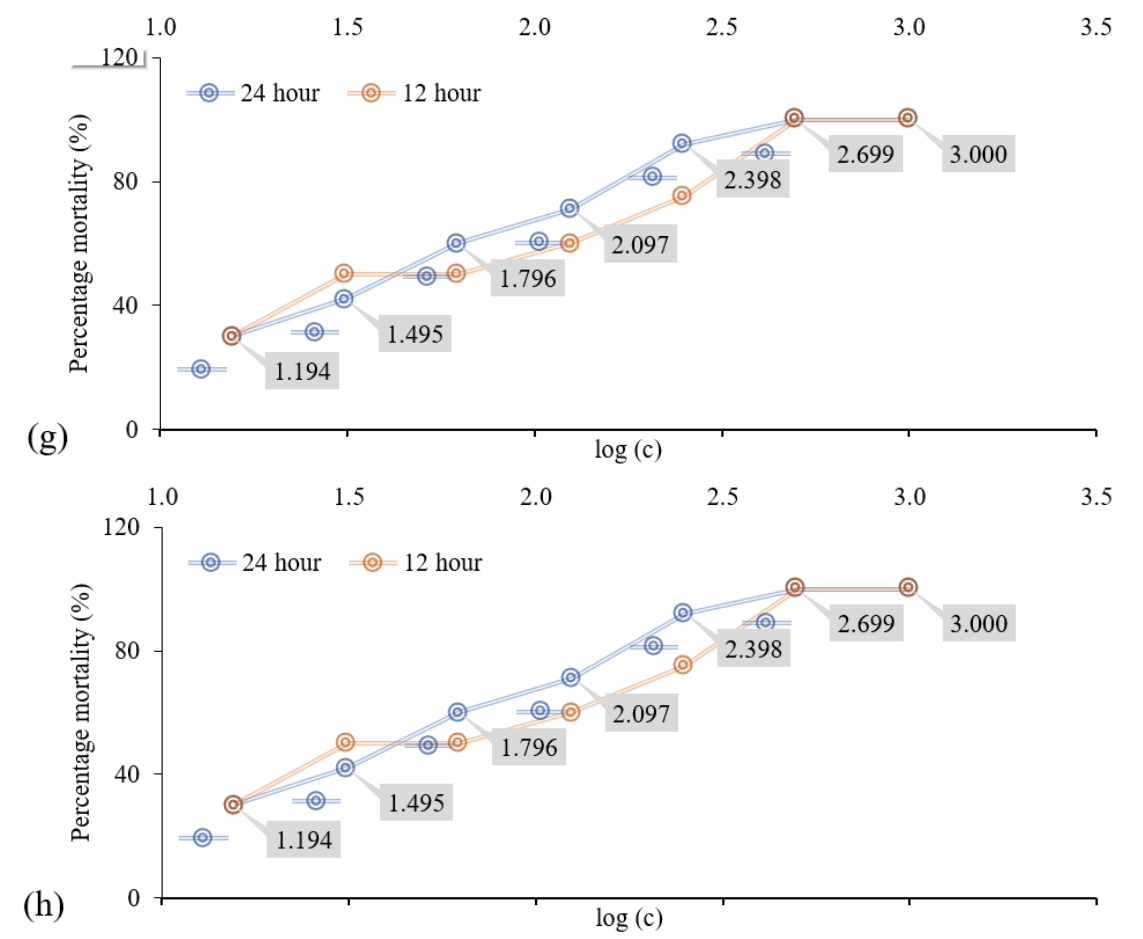
Figure 2. Cytotoxicity of ( a ) n-hexane, ( b ) ethyl acetate, ( c ) chloroform, ( d ) methanol, ( e ) aqueous, ( f ) vincristine sulphate, ( g ) etoposide and ( h ) potassium dichromate against logarithmic concentration after 12 and 24 h of exposure. Table 1. Cytotoxicity of different fractions of P. harmala (S) extract; LC 50 and R 2 values determined through logarithmic regression